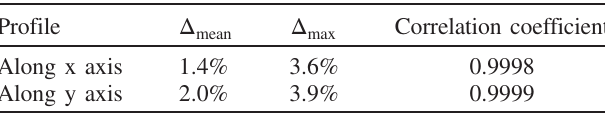
TABLE III. Mean ( Δ residuals calculated on the profiles shown in Fig. 9. Also, the correlation coefficient is reported.